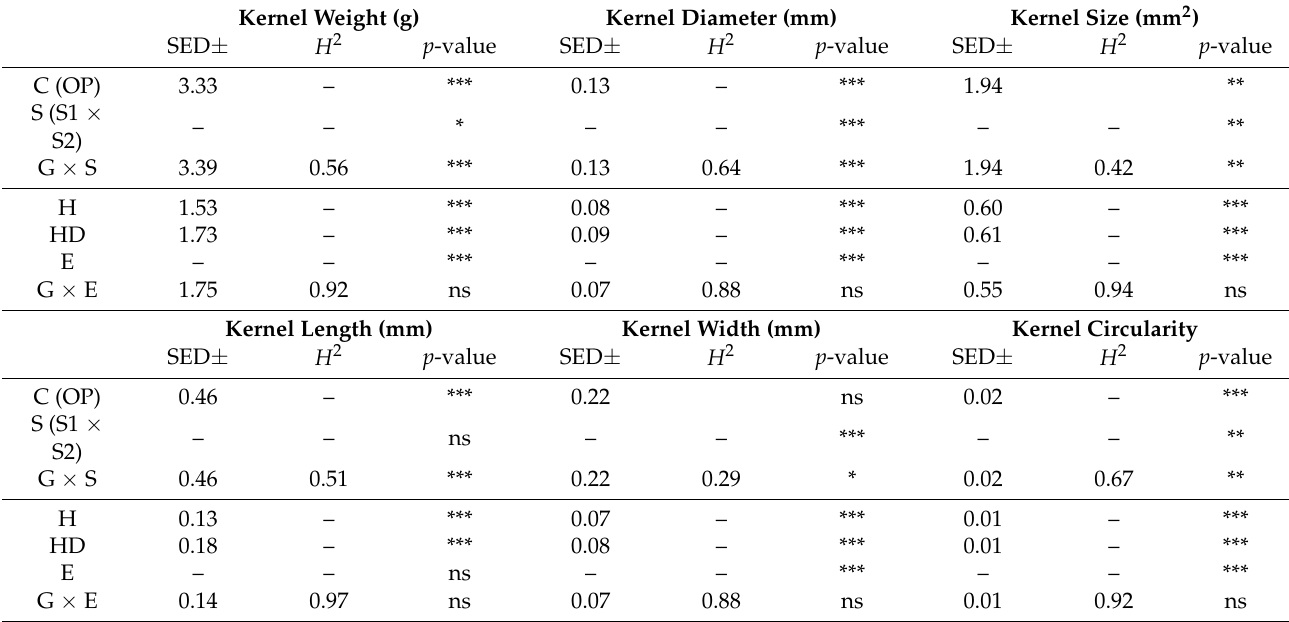
Table 1. Analysis of variance and heritability of kernel weight and shape-related traits under optimum (OP), heat (H) and combined heat–drought (HD) conditions for multiple synthetic derivatives